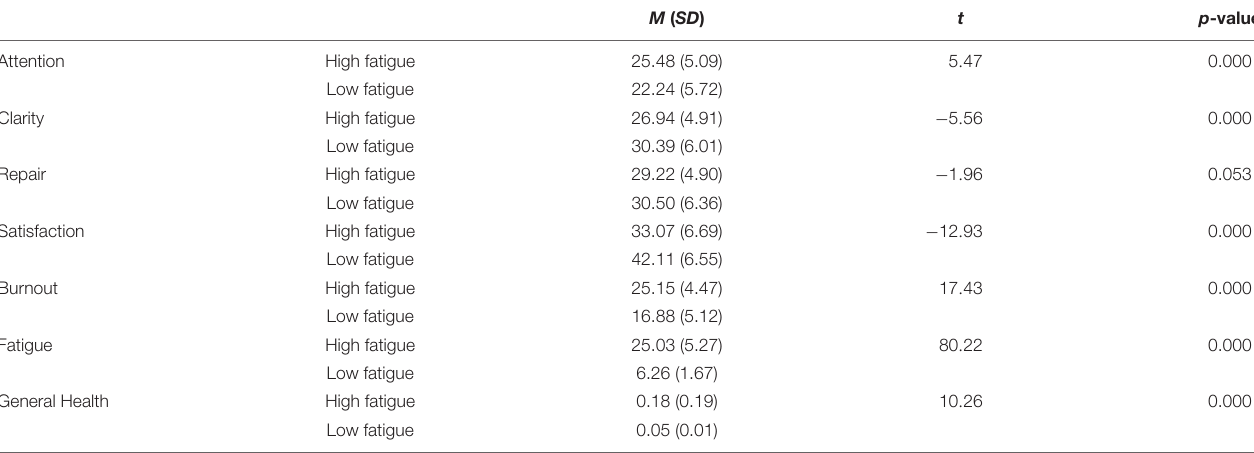
TABLE 3 | Student’s t -test.